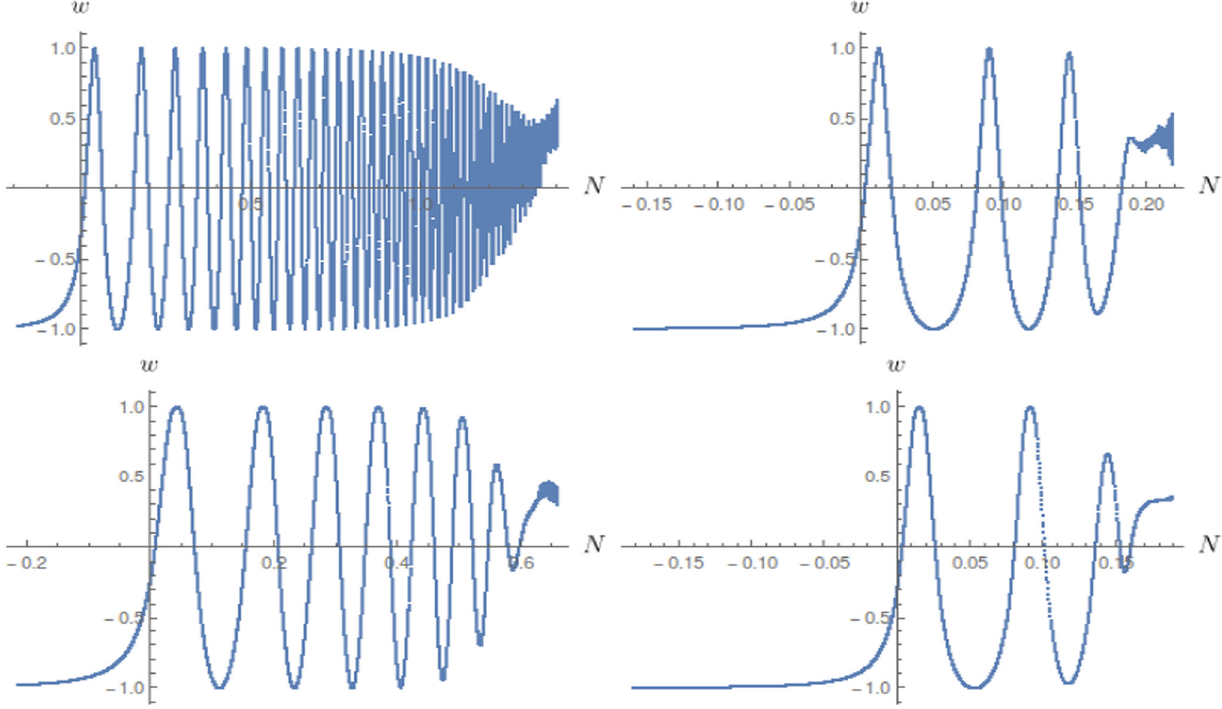
Fig. 12 The evolution of the barotropic parameter w (not averaged) for n = 1 , α = 10 − 3 (upper left), n = 1 , α = 10 − 4 (upper right), n = 1 . 5 , α = 10 − 3 (lower left), n = 1 . 5 , α = 10 − 4 (lower right). N is the number of e-folds after the end of inflation. These results were obtained on a lattice with N lattice = 64